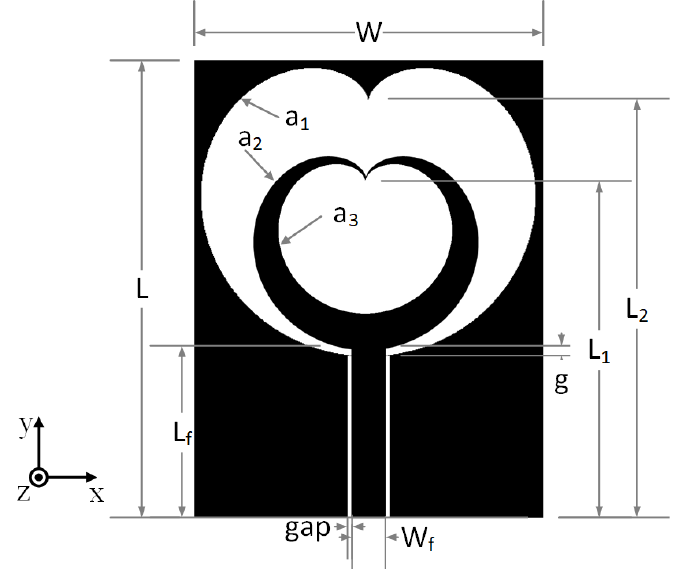
Figure 1. The geometry of the proposed fractal antenna. The metal is shown in black. Relevant dimensions of the antenna are as follows: W = 35.1 mm, L = 47.5 mm, gap = 0.25 mm, W f = 2.85 mm, L f = 16.4 mm, g = 0.40 mm, L 1 = 34.45 mm (distance from the cardioid center), L 2 = 42.43 mm, a 1 = 6.6, a 2 = 4.68 and a 3 =